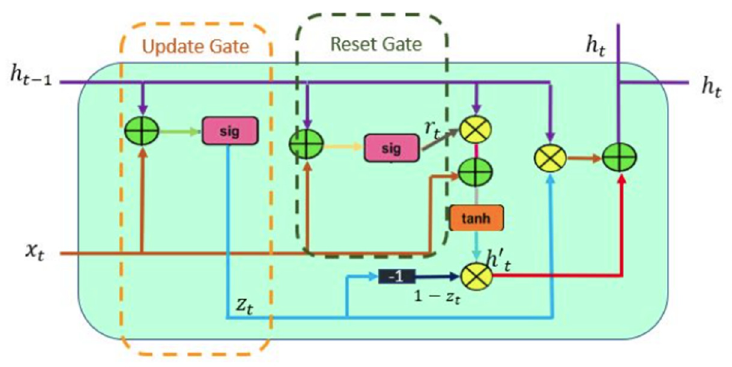
Figure 18. GRU structure overview, [43].